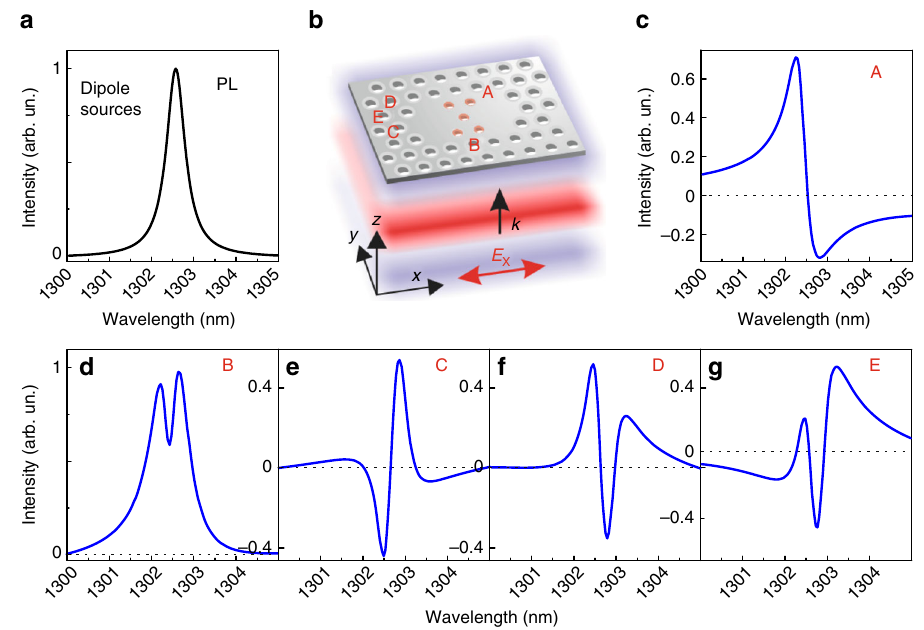
Fig. 3 Finite-difference time-domain calculations of near- fi eld resonant scattering in proximity to the exceptional point. a The near- fi eld spectrum obtained by employing dipole light sources embedded in the slab, thus resembling the photoluminescence experiment, results in a Lorentzian line. b Schematic of the photonic molecule: fi ve central air pores (red circles) are reduced to tailor the coupling. The sketch shows a resonant-scattering simulation where a polarized plane wave is impinging on the slab from the bottom. The plane wave is characterized by the blue and red wavefronts, the wavevector k and the electric fi eld polarized along the x -direction. A, B, C, D, and E indicate the positions where the spectra reported in c – g are evaluated. c – g Near- fi eld spectra of the RS transmission evaluated by employing the layout reported in b . The spectrum in c is a standard Fano pro fi le. d – g Spectra exhibiting generalized Fano pro fi les with 0, 1, 2, 3 crossings with the zero-value baseline,